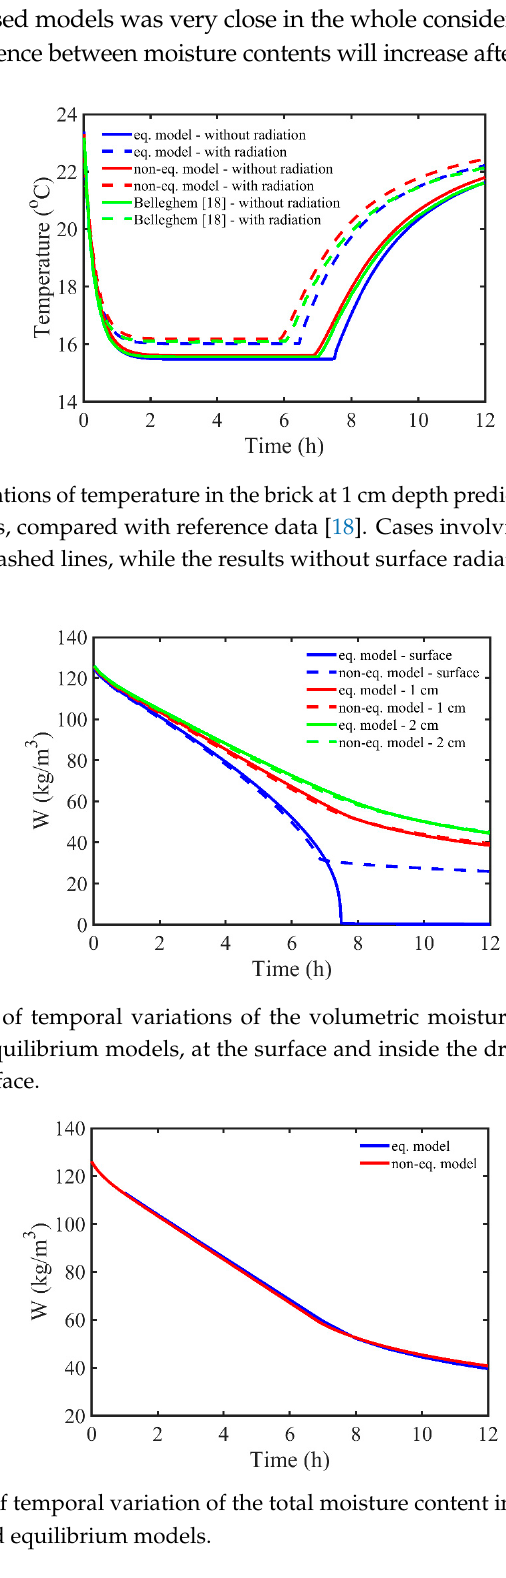
Figure 6. Comparison of temporal variation of the total moisture content in the brick predicted with the non-equilibrium and equilibrium models. the non-equilibrium and equilibrium